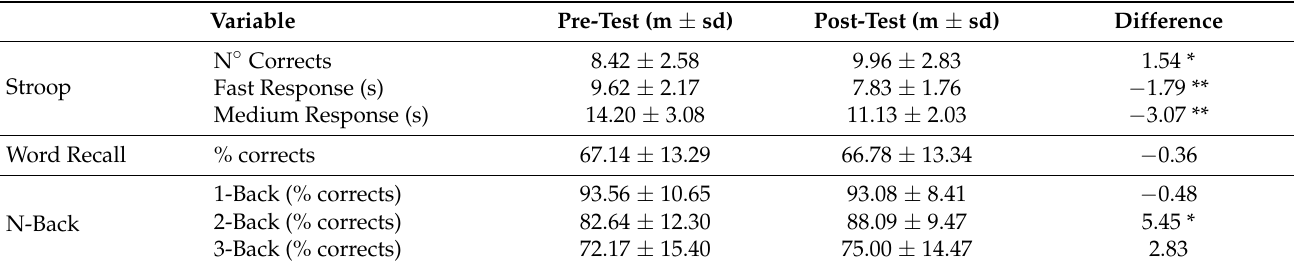
Table 3. MICT Group. Descriptives of pre-test, post-test and